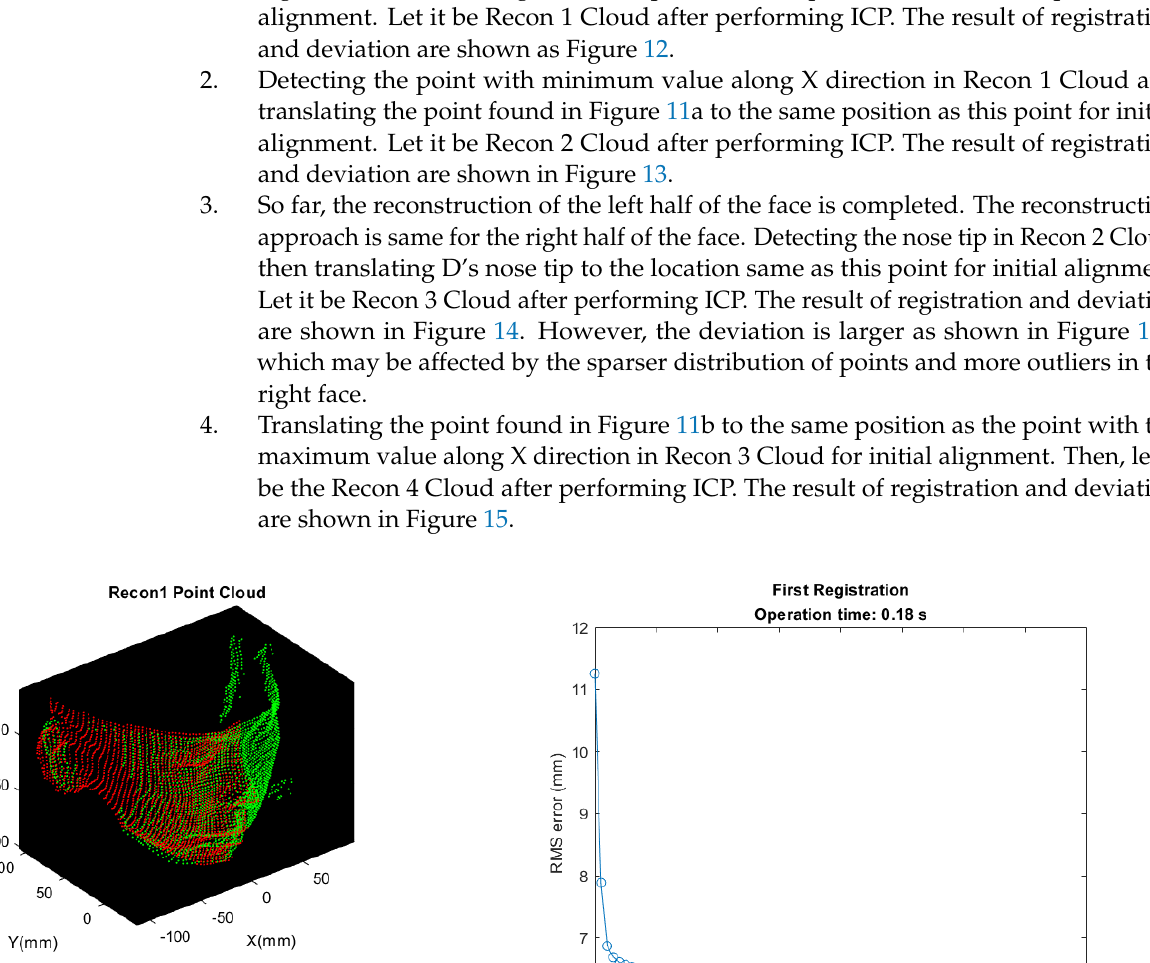
Figure 11. Detection of extremum points along X direction, both are marked as red point: ( a ) point with minimum value along X axis of C point cloud; ( b ) point with maximum value along X axis of E point cloud.